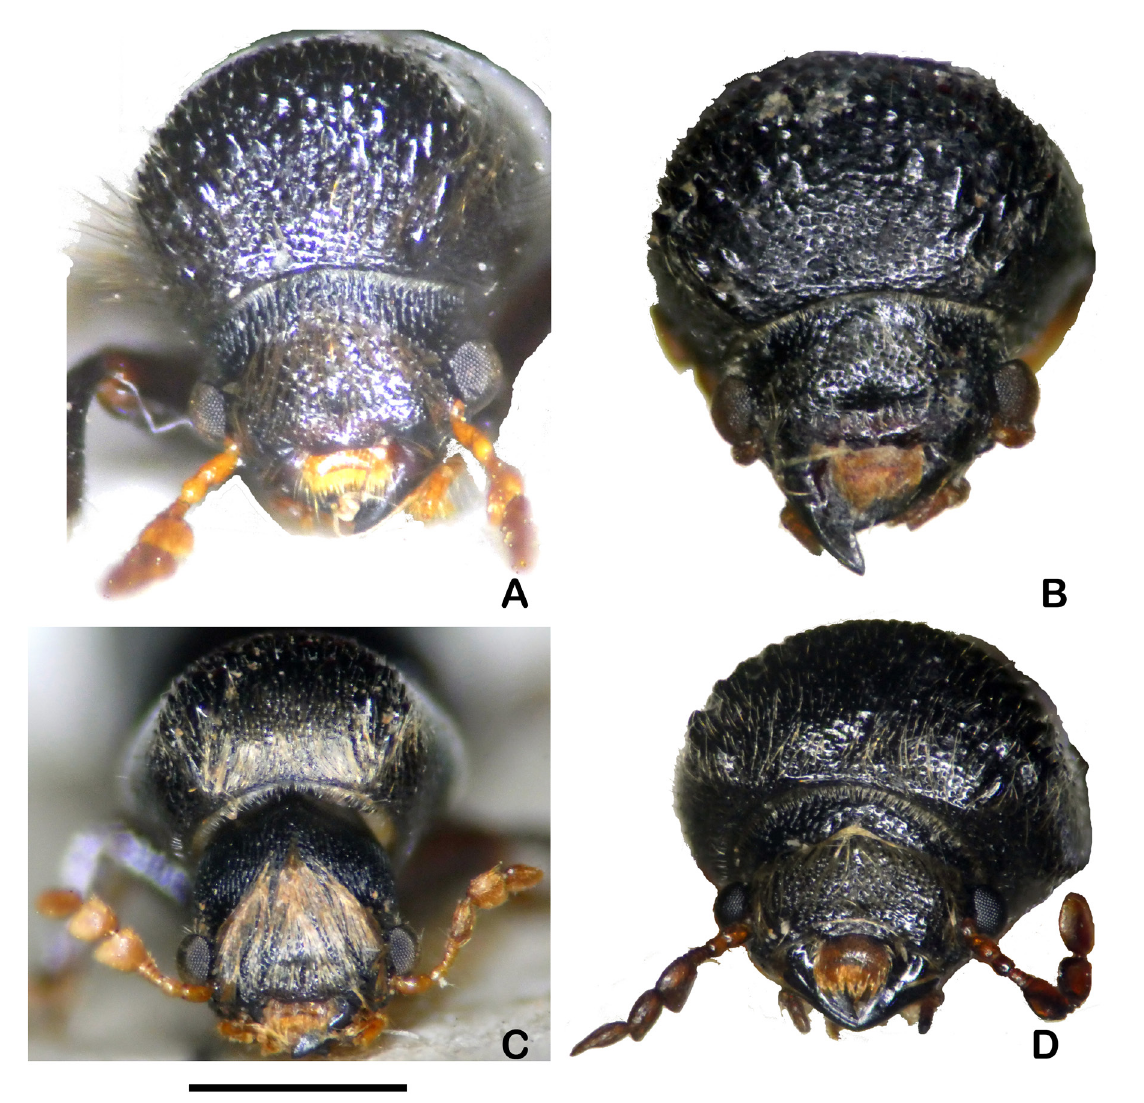
Fig. 2. Frontal view of the females of species of Xylopertha Guérin-Méneville, 1845. A . Xylopertha retusa (Olivier, 1790). B . X. praeusta (Germar, 1817). C . X. elegans sp. nov. D . X. reflexicauda (Lesne, 1937). Scale bar = 1